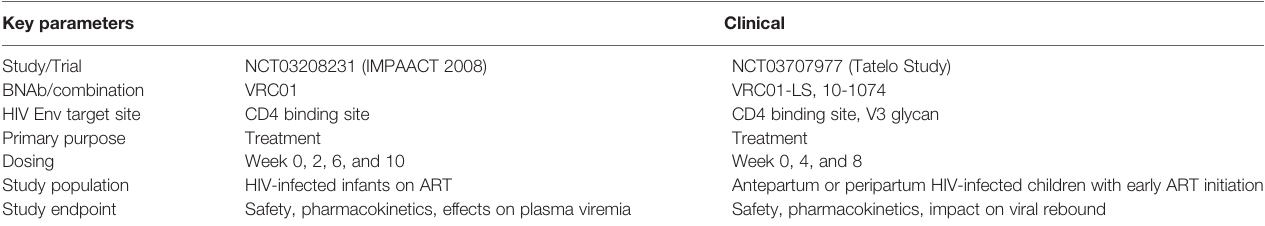
TABLE 2 | Antibody (bNAb) therapy for pediatric HIV treatment. Key parameters Clinical